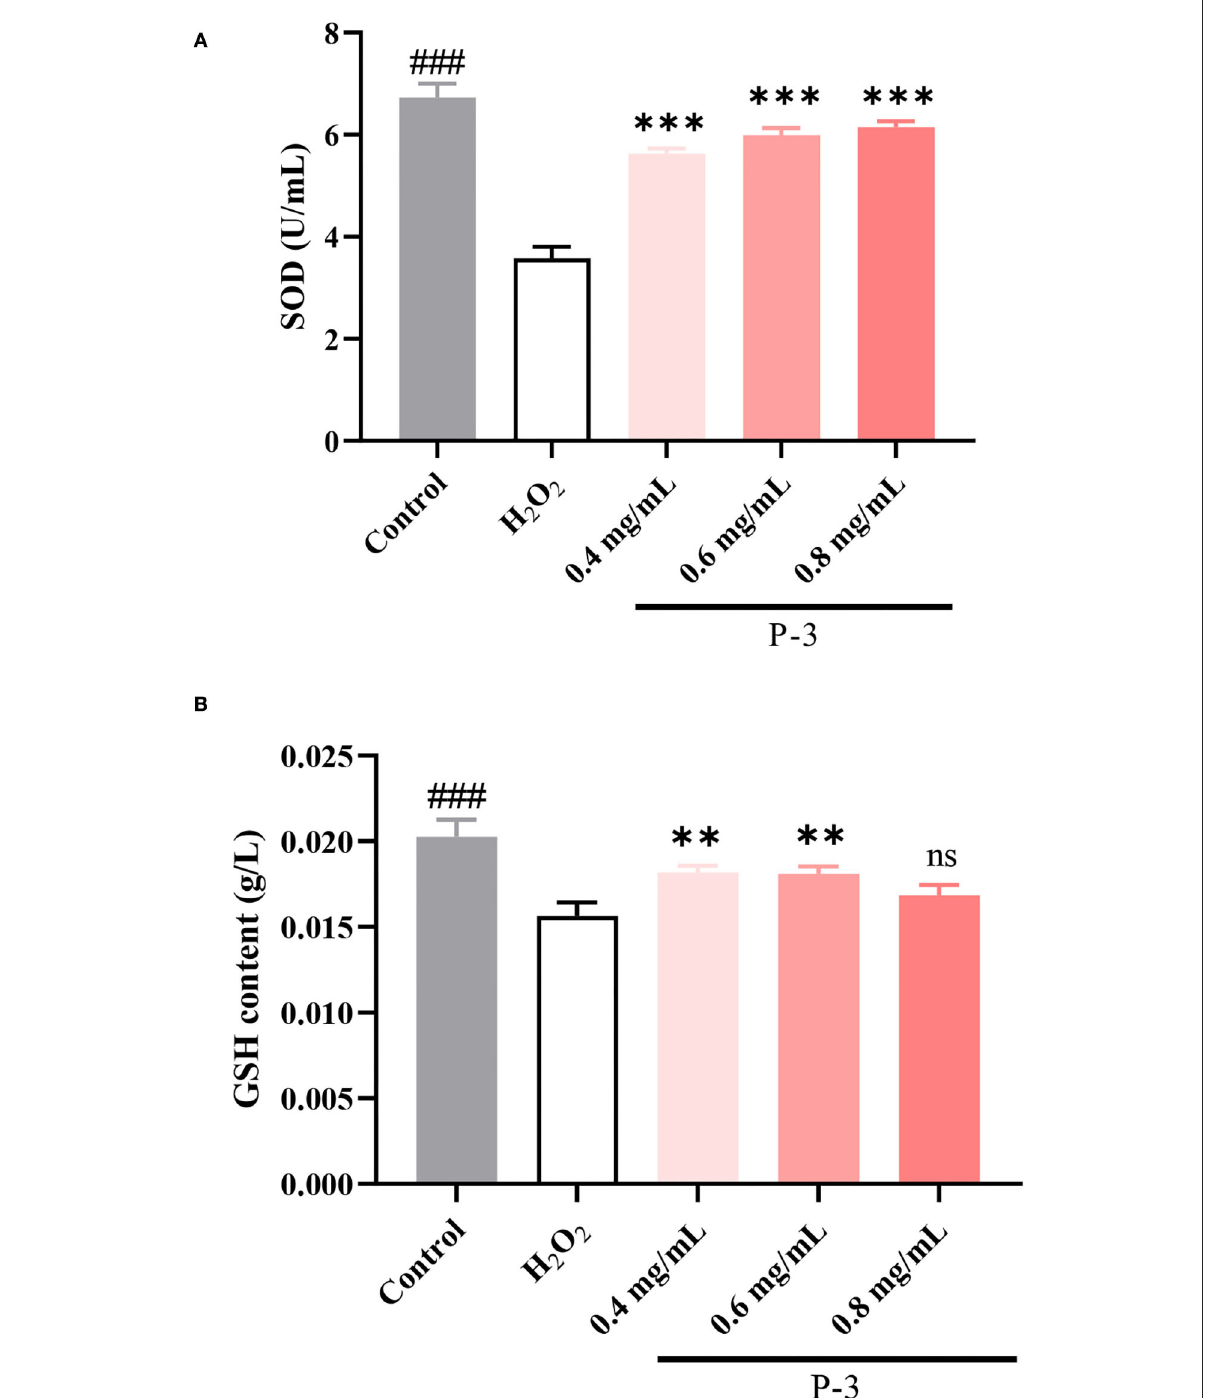
FIGURE6 (A) SOD activity and (B) GSH content of 1.4mM H 2 O 2 -induced HSF cells after treatment with 0.4, 0.6, and 0.8 mg/ml P-3 for 24h. The HSF cells only treated by DMEM for 24h were used as blank. Control was treated with 1.4mM H 2 O 2 for 1h. ** and ***indicate the differences between P-3 and the control at p -values of < 0.05 and < 0.001, respectively. ### indicates the differences between blank and control at a p -value of <